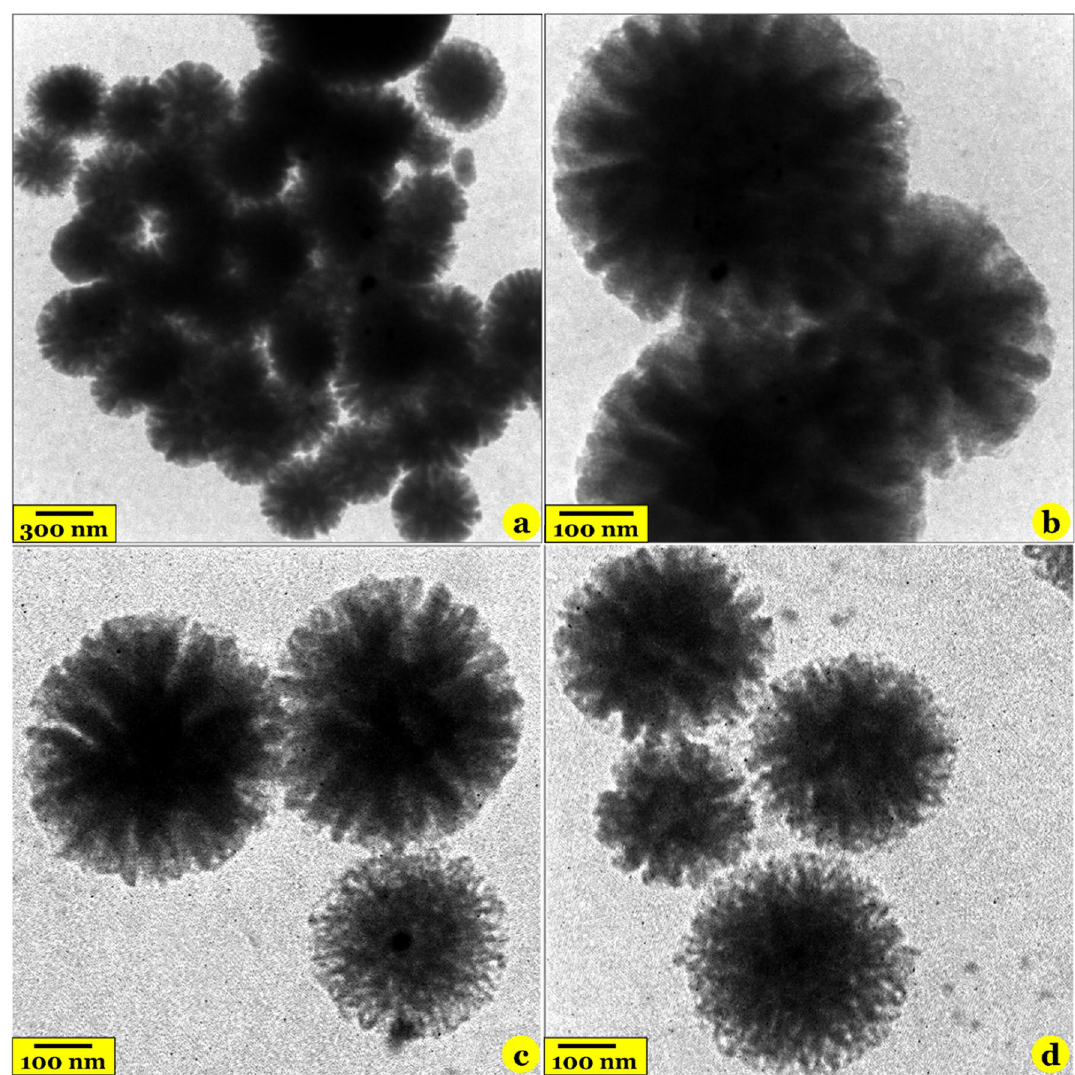
Figure 3. TEM images of the pure KCC-1 ( a and b ) and MF-KCC-1 ( c and d